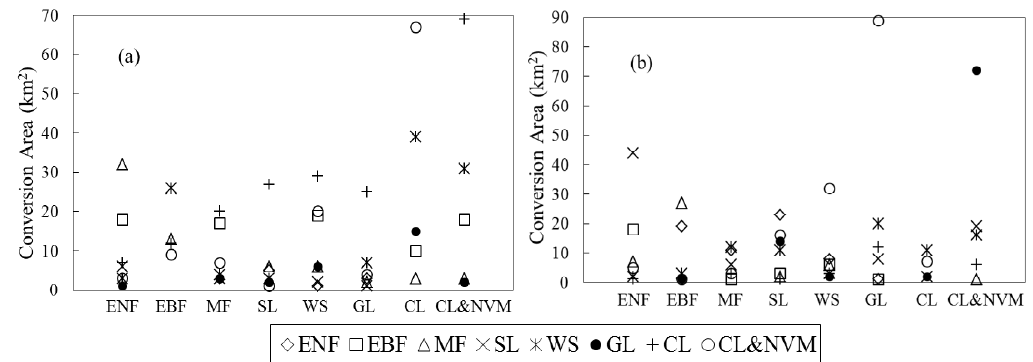
Figure 3. Conversion areas among land use/land covers during ( a ) 2001–2003, ( b )